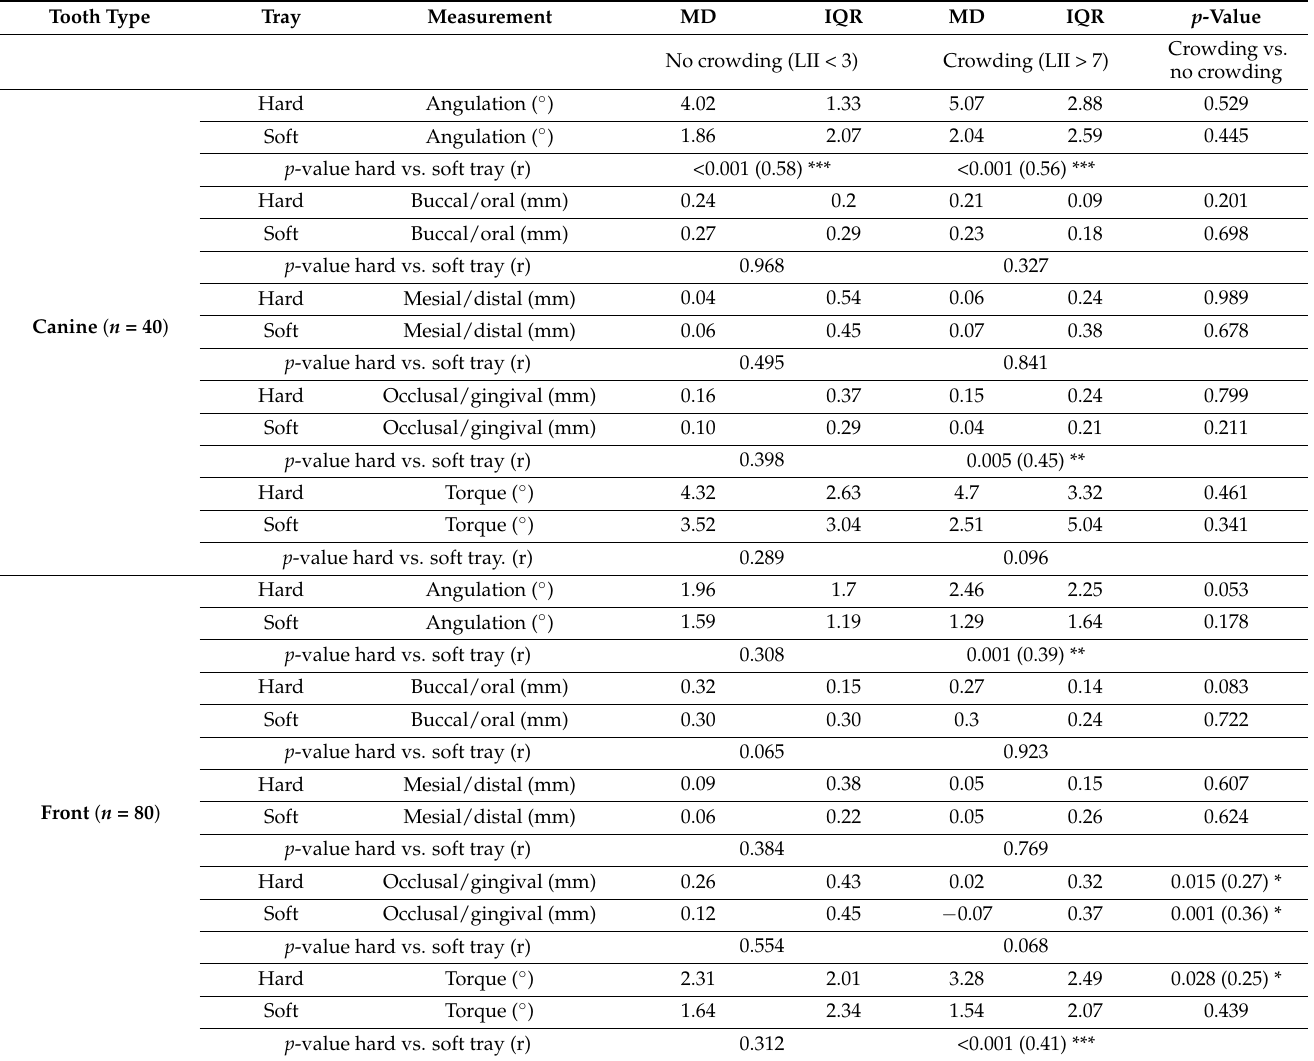
Table 1. Descriptive statistics for the subgroup analysis of the bracket transfer accuracies for linear and angular measure- ments. Results are summarized for the canines, front teeth, molars, and premolars and split up into hard/soft trays and no crowding/crowding. A positive/negative value indicates mesial/distal, buccal/oral or occlusal/gingival displacement. Medians (MD) and interquartile ranges (IQR), mm or degree are given. Comparison between crowding vs. no crowding groups and hard vs. soft trays was performed using the Mann–Whitney U-test. The p -values for comparison of hard vs. soft trays are presented in the lines, for crowding vs. no crowding in the right column. Pearson -correlation coefficient (r) was calculated in addition to measure the effect size, and was interpreted as follows: <0.3 low, 0.3–0.5 medium, >0.5 good effect